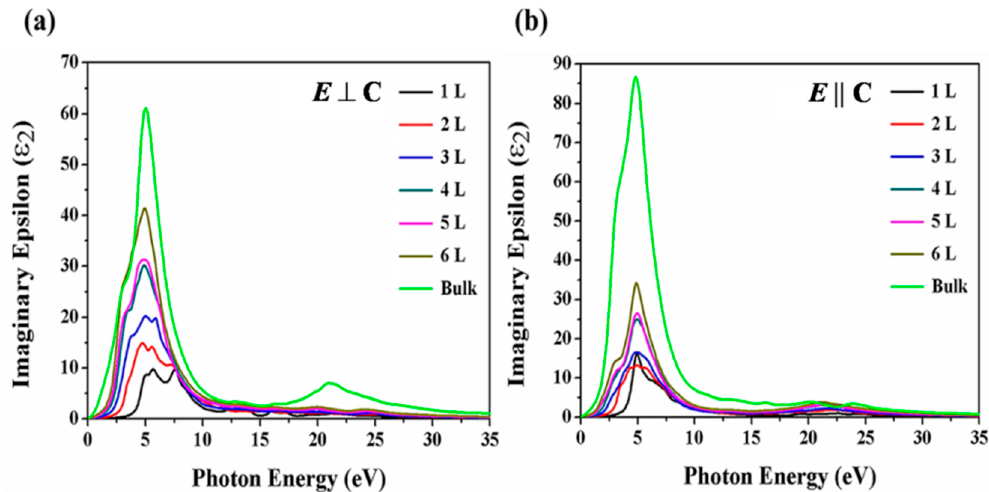
Figure 4. Calculated imaginary part of the dielectric function along ( a ) E ⊥ C and ( b ) E || C polarization directions of the few-layer Te and bulk Tellerium.